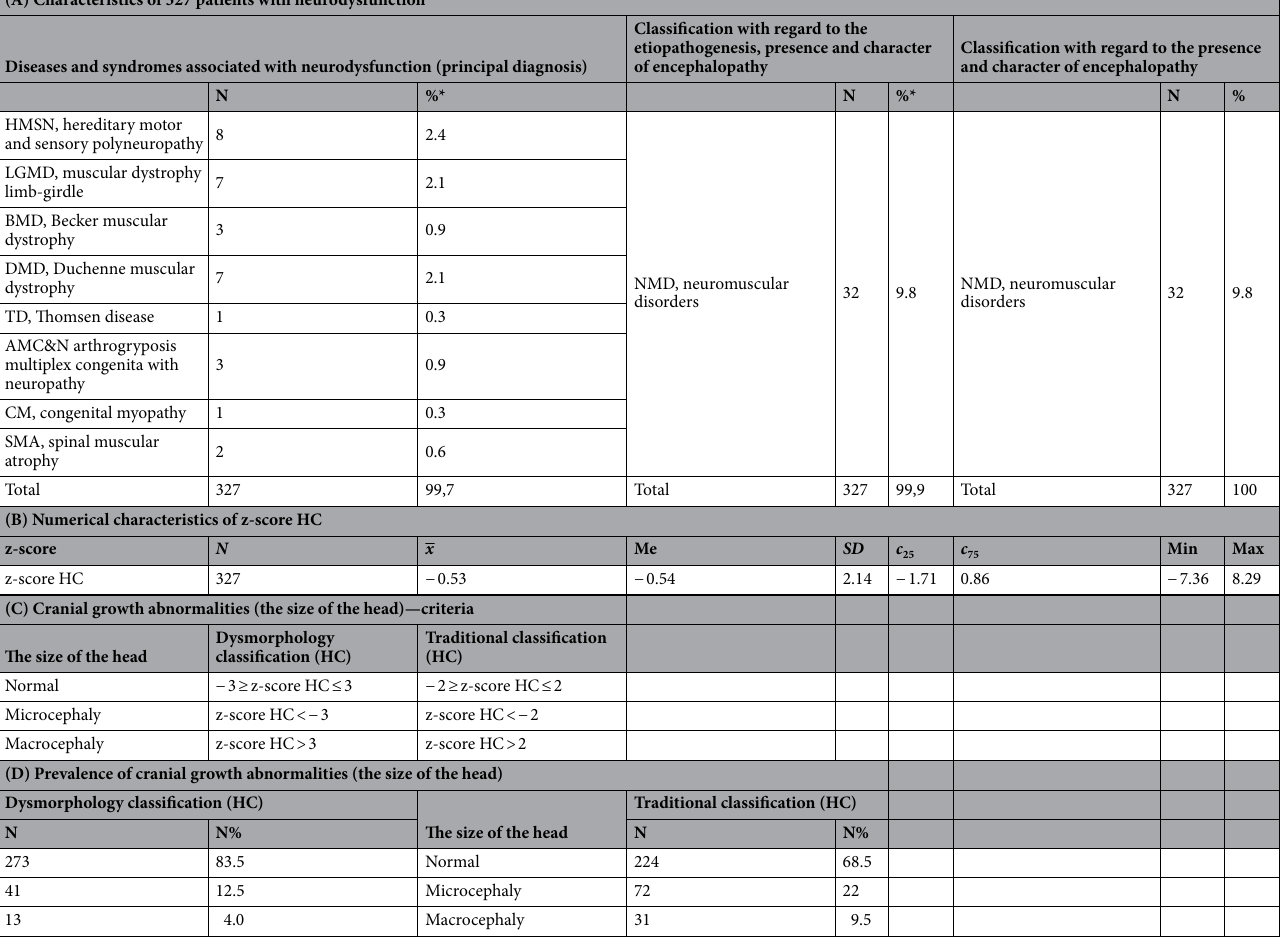
Table 1. Characteristics of the study group (A) and abnormal cranial development (B–D). N numbers of patients, % percent, z-score HC z-score for head circumference, SD standard deviation, Min minimum value, Max maximum value. a The percentages have been rounded to one digit after the decimal point, so the total value is 99.7% and 99.9% instead of